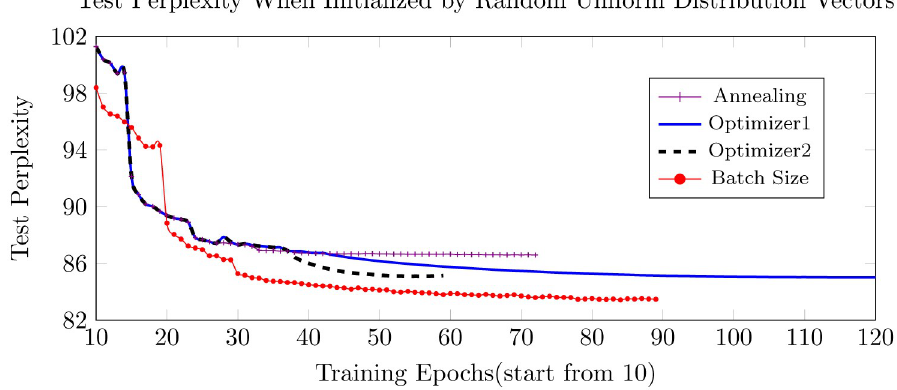
Fig 5. Test perplexity when initialized by uniform distributed vectors.